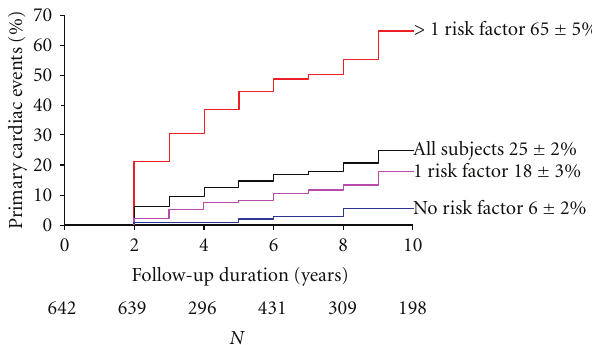
Figure 4: Outcomes in BAV patients (from Tzemos et al.